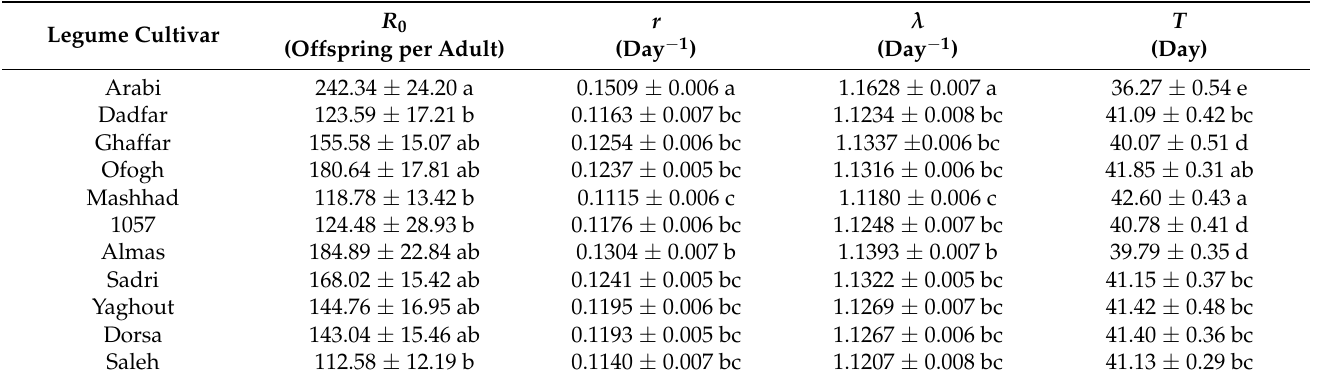
Table 3. Life table parameters of Spodoptera littoralis reared on various legume cultivars. Legume